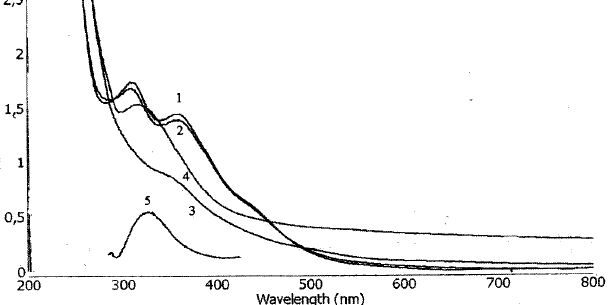
mmol in 16 mL) in 200 mmol HEPES buffer, pH 7,4. During decomposition of the complex in the